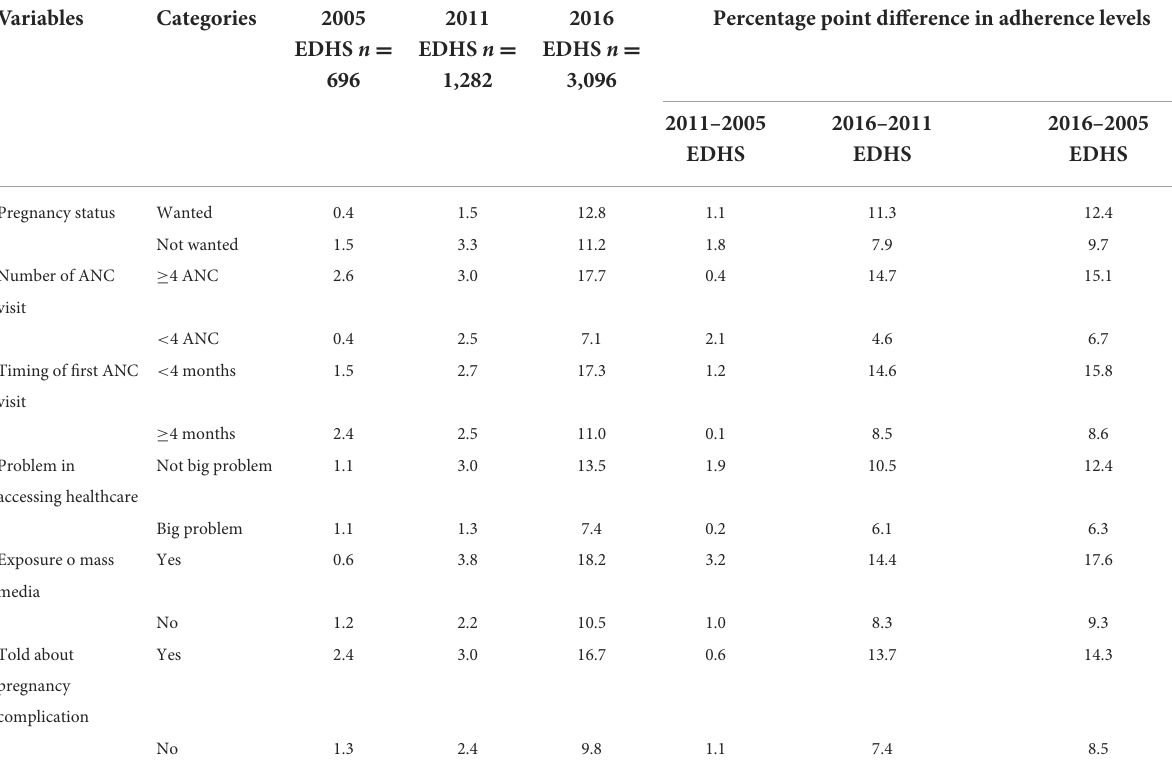
TABLE 4 Proportion of respondents in Ethiopia who adhere to iron supplementation based on health-related characteristics (EDHS